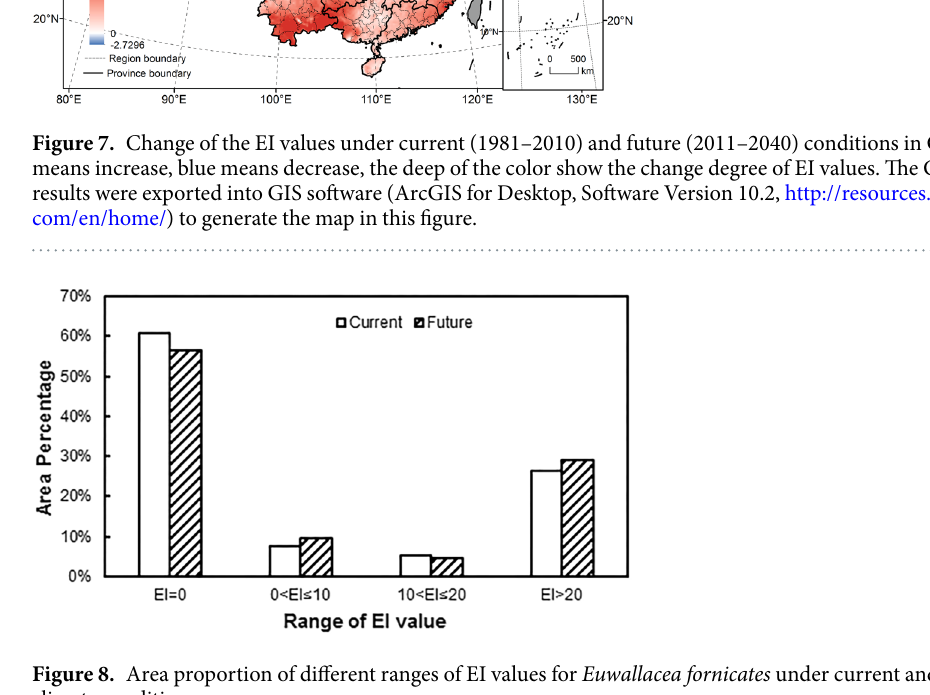
Figure 8. Area proportion of different ranges of EI values for Euwallacea fornicates under current and future climate